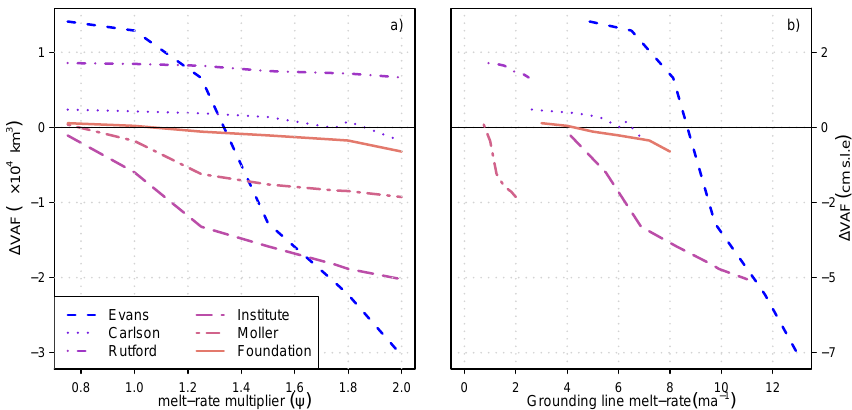
Figure 7. Total volume above flotation change by ice stream catchment over the 2000-year model runs as a function of (a) ψ and (b) the melt rate at the ice stream grounding line at t = 0